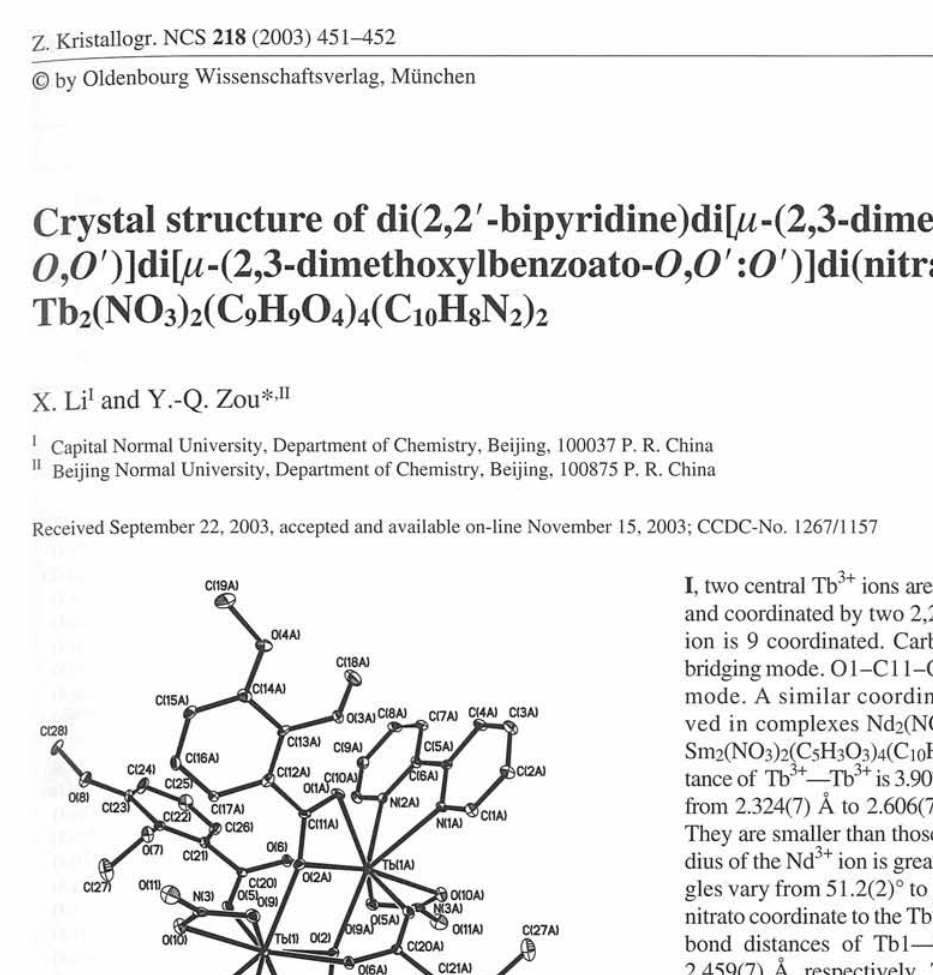
Table 1. Data collection and handling.